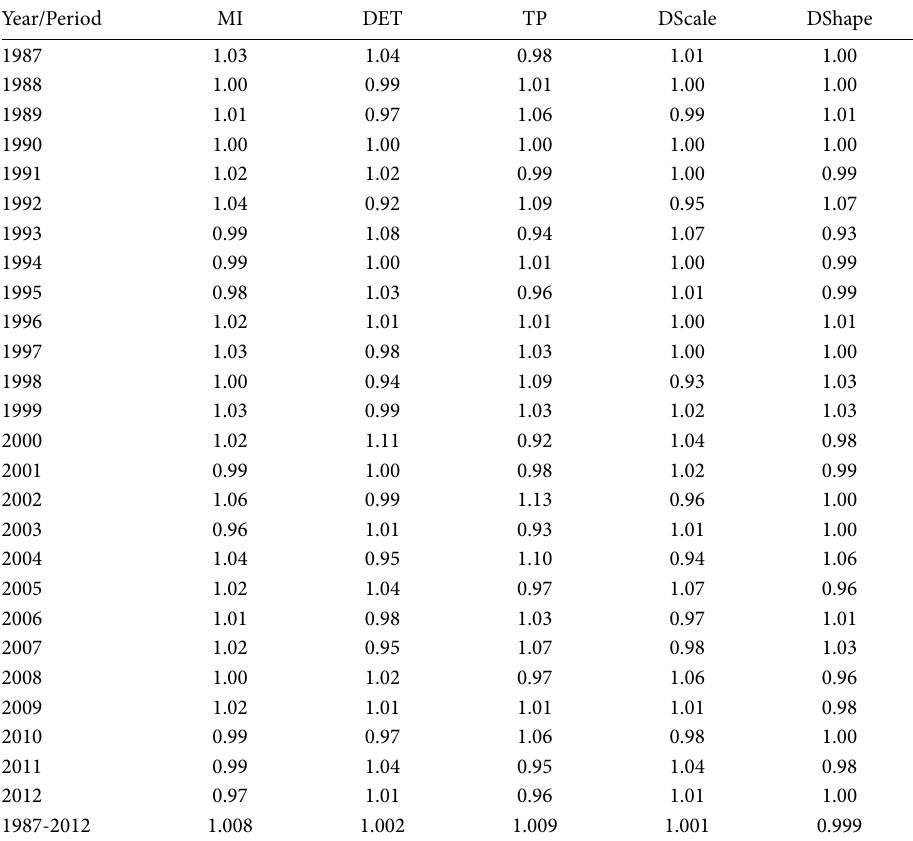
Table 4. Geometric mean of annual productivity growth components in